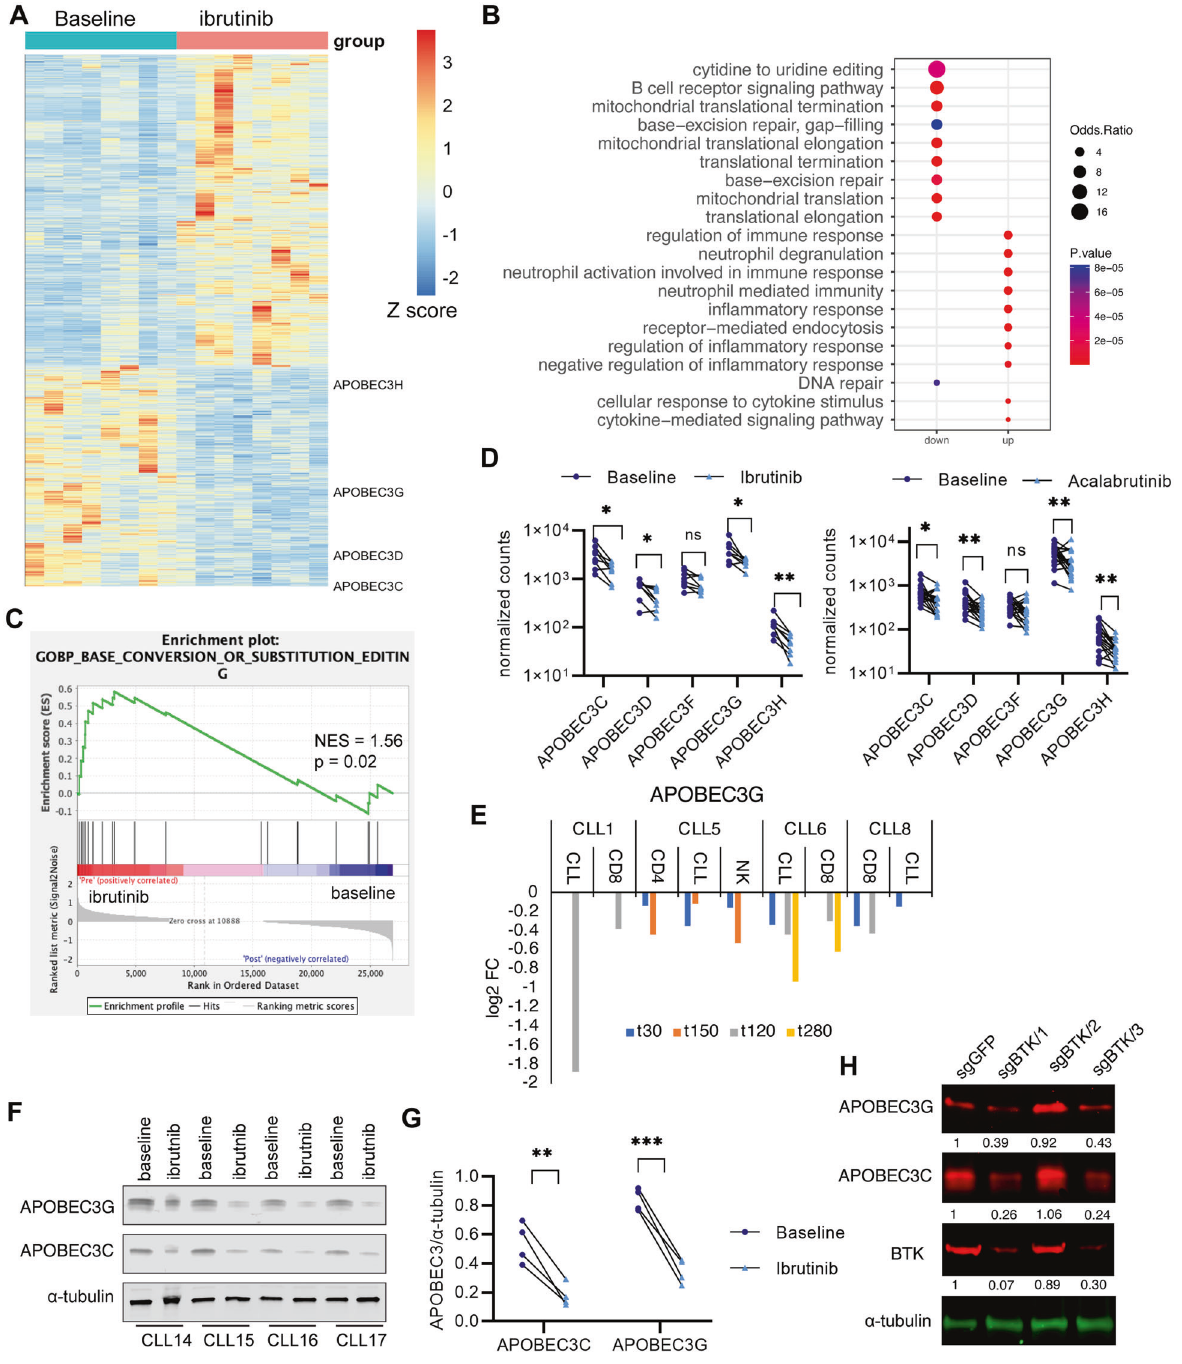
Fig. 1 BCR signaling-dependent APOBEC3 expression in CLL B cells. A Heatmap representing the expression of signi fi cant changes in genes ( = 3334, up = 1964, down = 1370. p < 0.05, fold change >1.5) (in CLL B cells from the same CLL patients before and with one-year continuous ibrutinib treatment. The gene expression was determined by RNA-seq, n = 8 patients. B Gene Ontology (GO) enrichment analysis for the ibrutinib suppressed genes. CLL B cells were harvested from the same CLL patients before and with one-year continuous ibrutinib treatment and the gene expression was determined by RNA-seq, n = 8 patients. C Gene set enrichment analysis showing enrichment of base conversion or substitution editing linked genes in ibrutinib pretreated CLL B cells compared to CLL B cells from patients with continuous 1-year ibrutinib treatment. D APOBEC3 gene expression changes in CLL B cells from ibrutinib-treated patients compared to that of pretreated patients. baseline = pre ibrutinib treatment; ibrutinib = 1-year of continuous ibrutinib treatment. E APOBEC3G expression in indicated cells from ibrutinib-treated patients. t30 means 30 days of ibrutinib treatment. F Immunoblot analysis of APOBEC3C and APOBEC3G in CLL B cells from patients before and after 1-year ibrutinib treatment. baseline = pre ibrutinib treatment; ibrutinib = 1-year ibrutinib treatment. G Quanti fi cation of the western blot intensity in panel ( F ). H Immunoblot analysis of APOBEC3C and APOBEC3G in MEC1 cells infected with indicated BTK sgRNAs, the intensity of each blot analysis was quanti fi ed and normalized against α -tubulin, with the normalized intensity of each blot in sgGFP control cells set to 1. The whole-cell lysates were harvested 5 days after